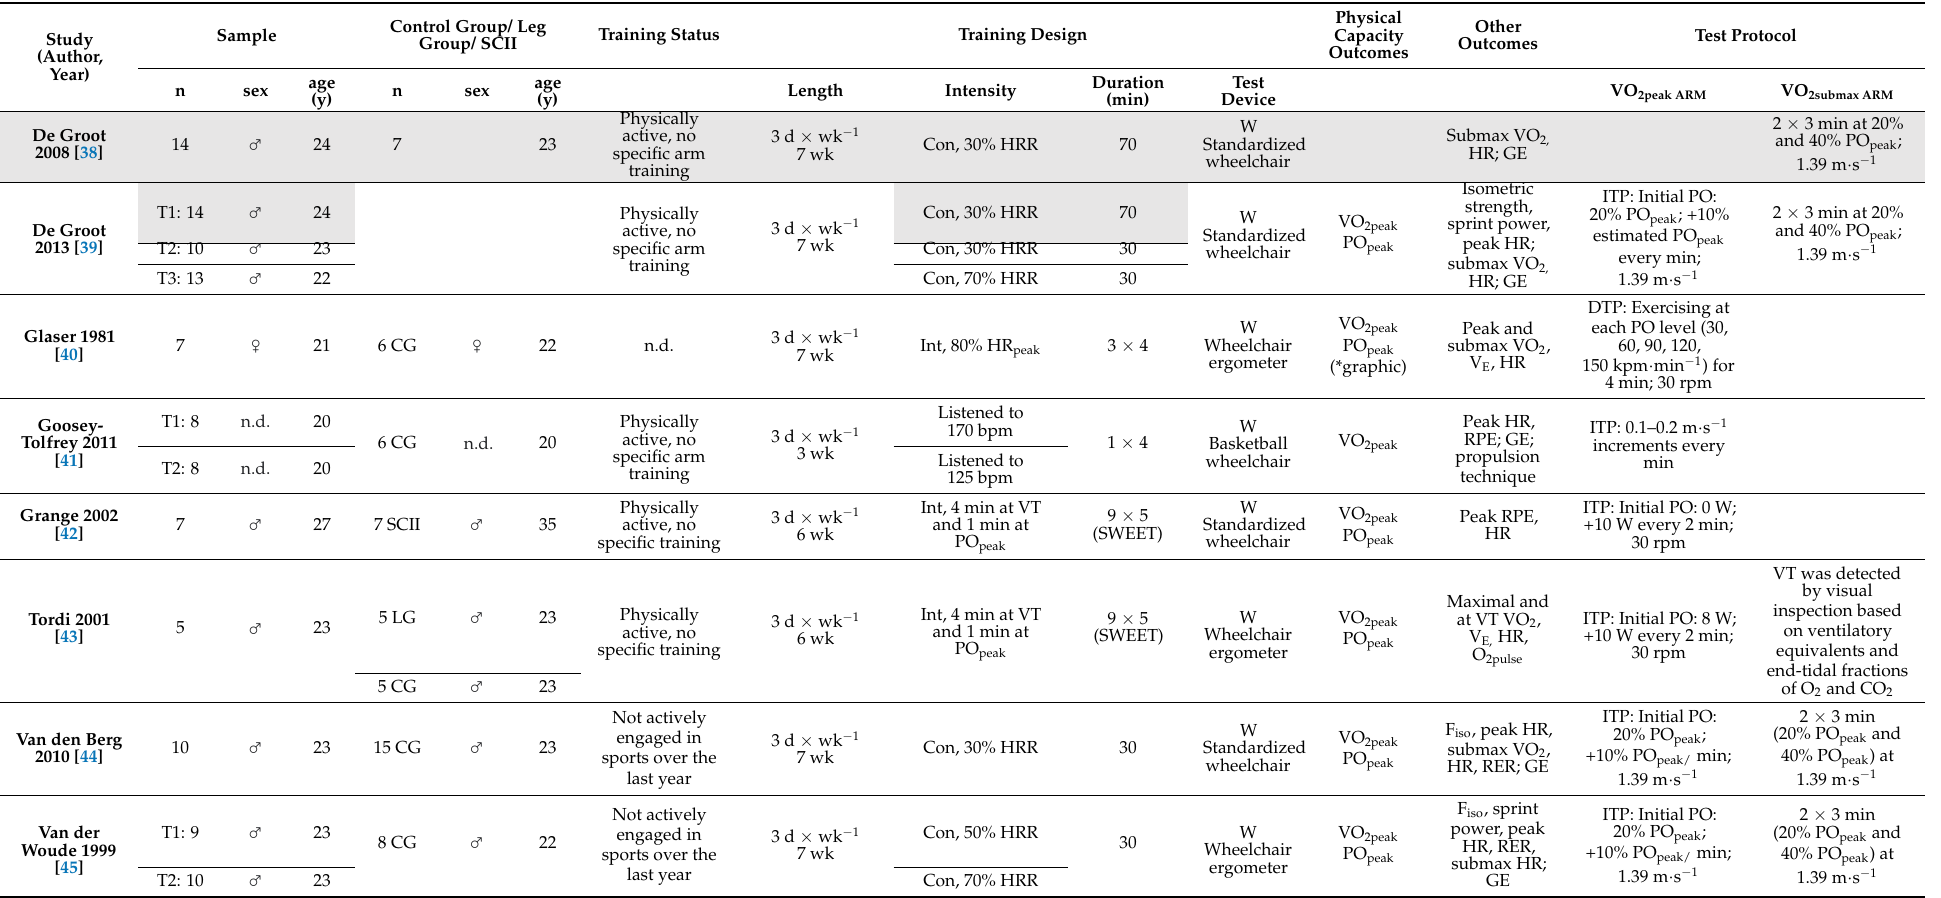
Table 2. Characteristics of studies evaluating the effects of wheelchair exercise (WCE) on aerobic